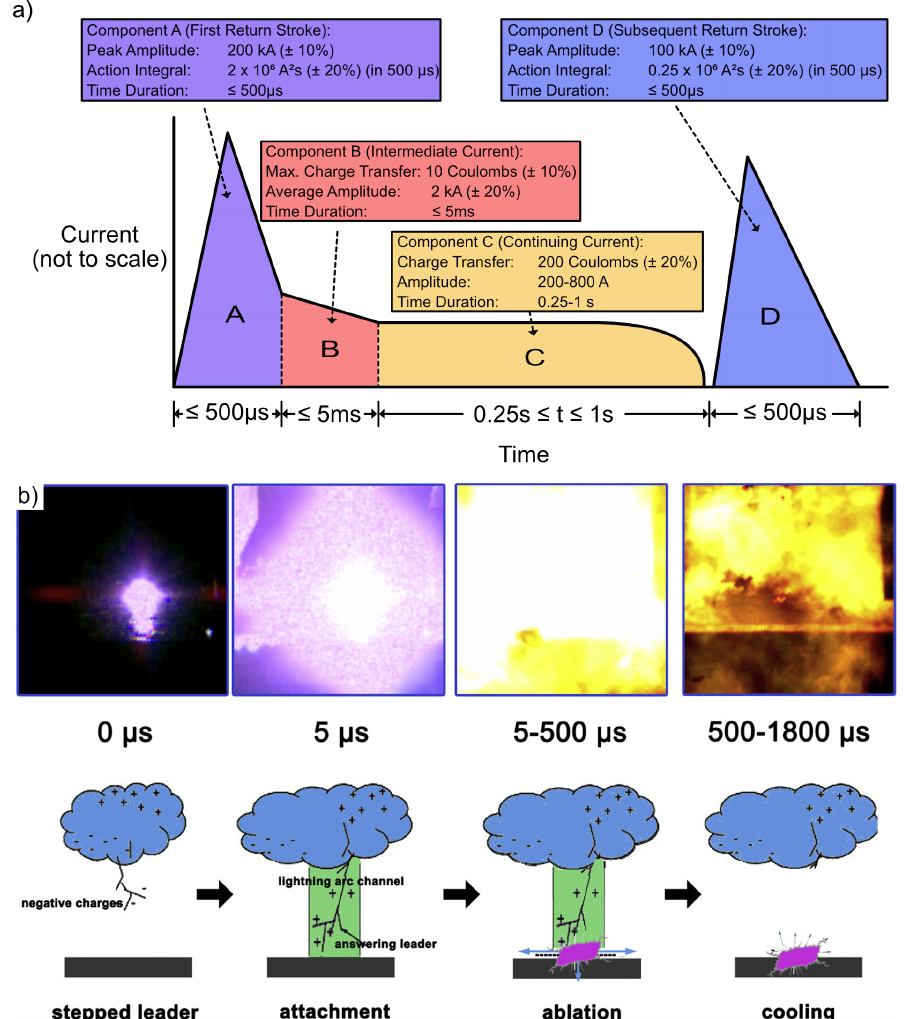
Figure 2. ( a ) Typical simulated lightning current waveforms according to SAE ARP 5412 (adapted from Feraboli et al. (2009) [7] under permission from Elsevier); ( b ) sequence of a lightning strike recorded with a high-speed camera (reprinted from Wang et al. (2020) [8] under permission from